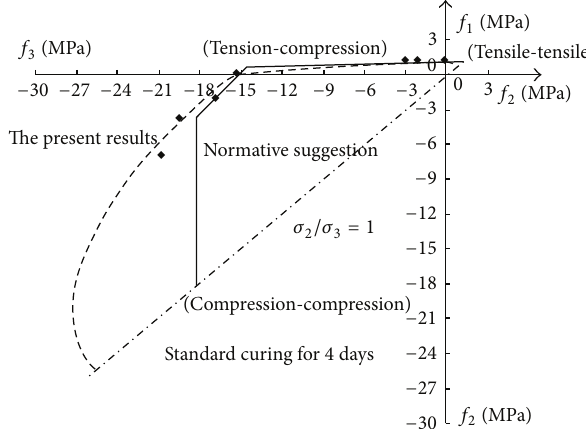
Figure 7: Biaxial ultimate strength envelope diagram of the C20 concrete after 3 d of standard curing.